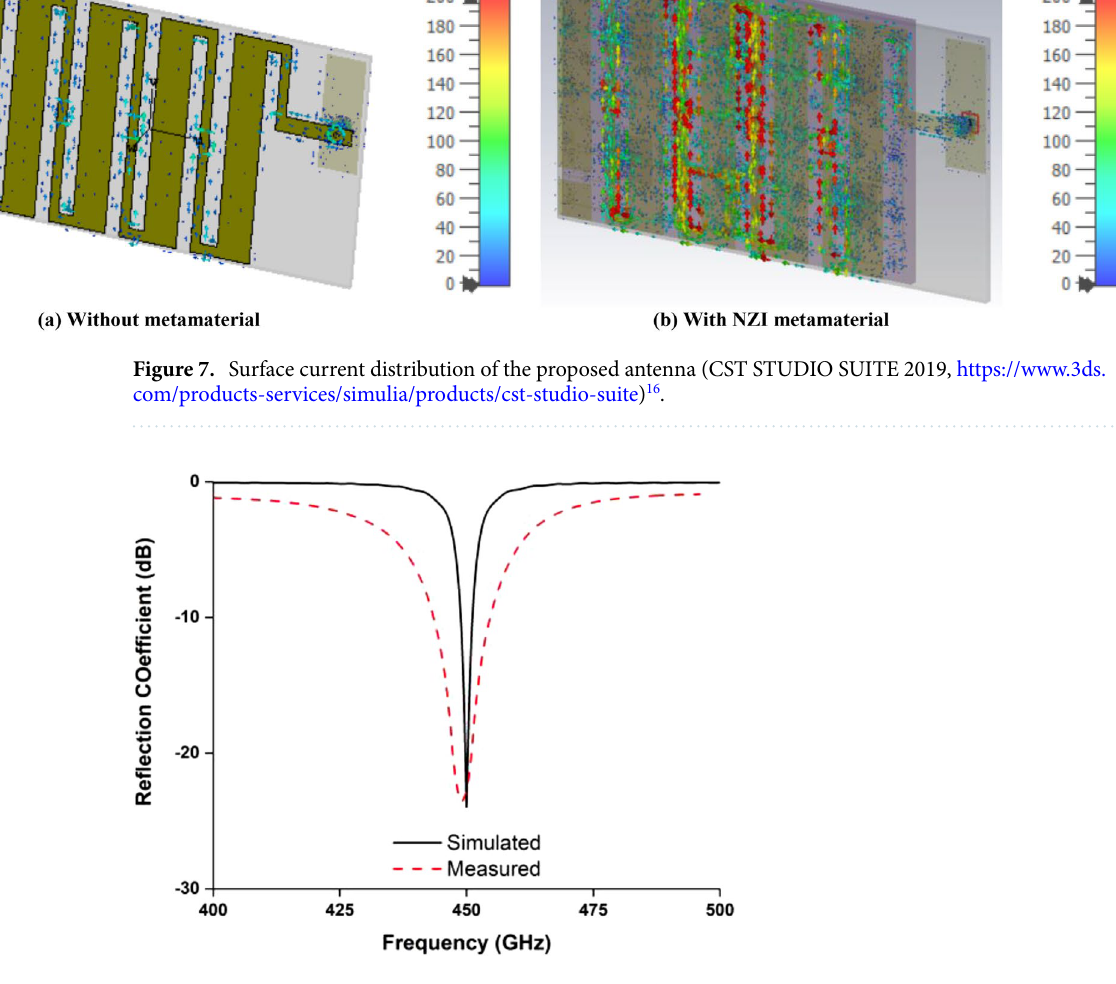
Figure 8. The numerical and experimental reflection coefficient of the optimized